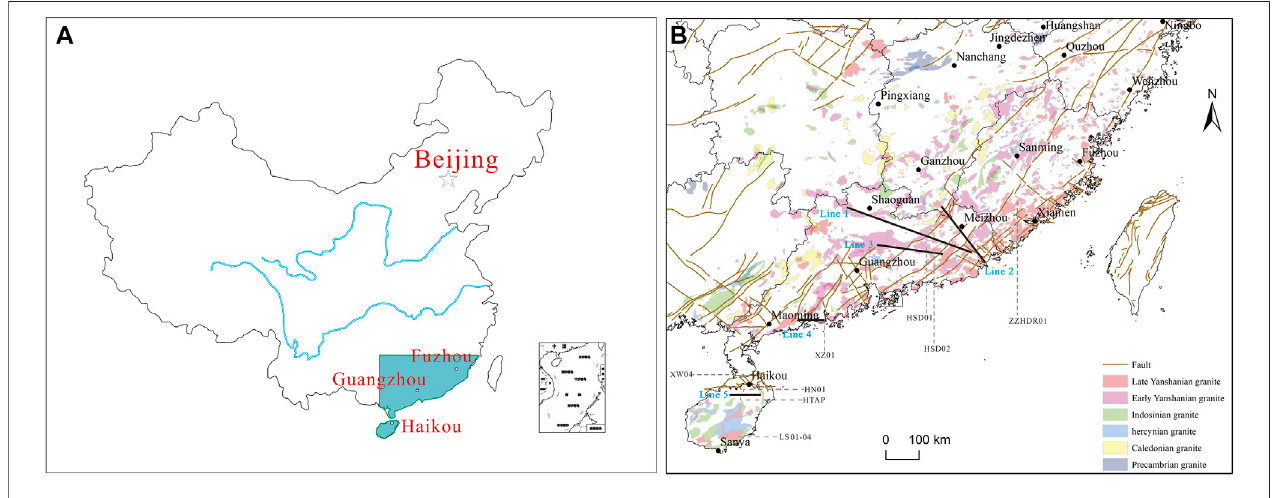
FIGURE 3 | Locations of typical MT sections in the IRRSC.